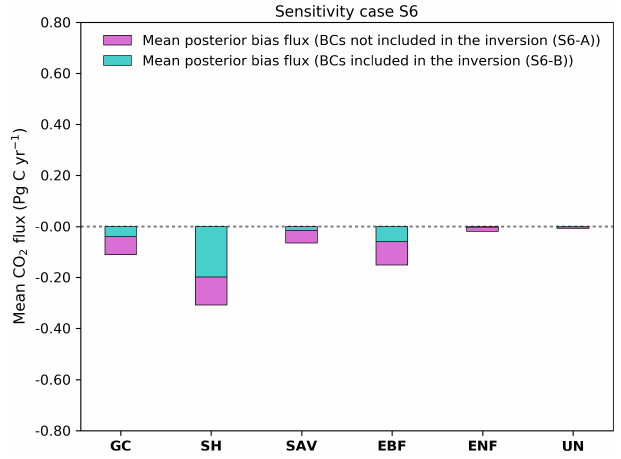
Figure 12. Posterior bias of monthly CO 2 concentration induced by changes in the lateral boundary conditions categorized by MODIS